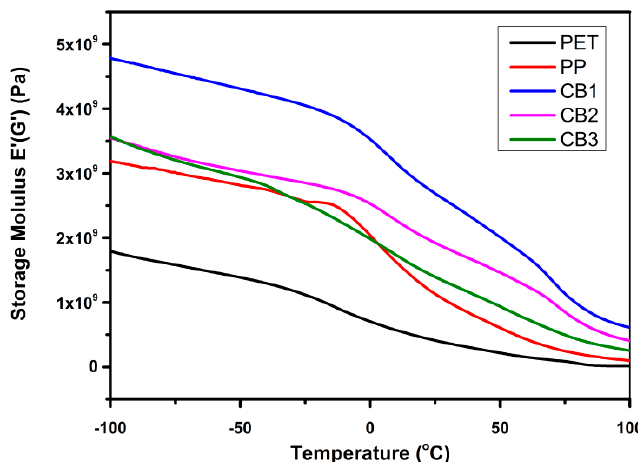
Figure 14. Variations in storage modulus by increasing temperature for prepared samples measured by DMA dual cantilever in bending mode.